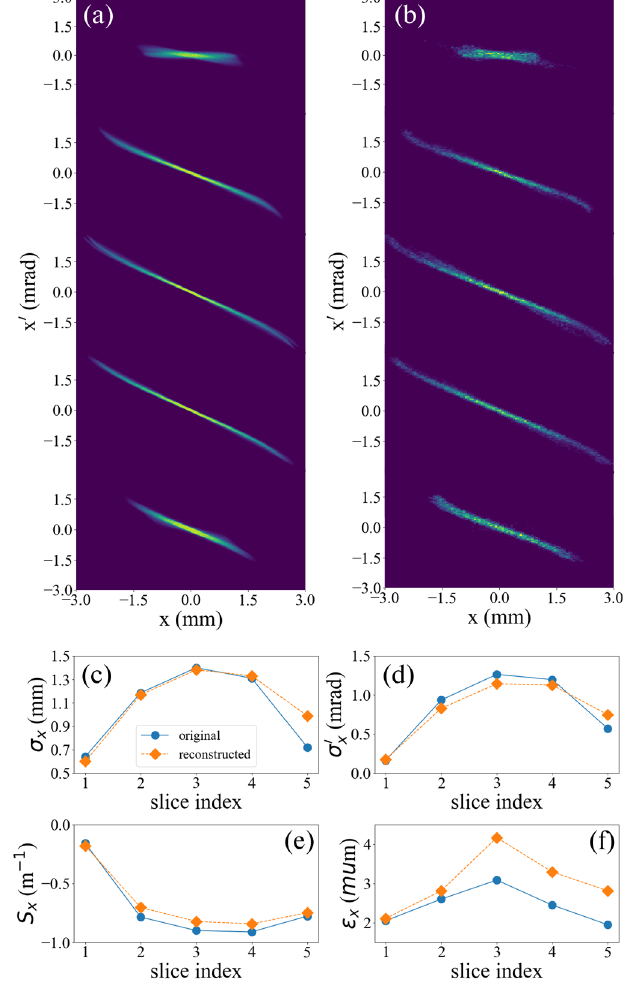
FIG. 12. Comparison of original and reconstructed slice phase spaces and second moments from start-to-end simulation. (a) x - x 0 phase space for different time slices. Each row corresponds to a time slice whose temporal center is f − 4 . 40 ; − 2 . 10 ; − 0 . 20 ; 1 . 75 ; 4 . 00 g ps with a temporal width of (cid:2) 0 . 6 ps. (b) Reconstructed x - x 0 phase space using the projection method. Each row corresponds to the case in (a). (c) – (f) are a comparison of original second moments and estimated second moments from the projection